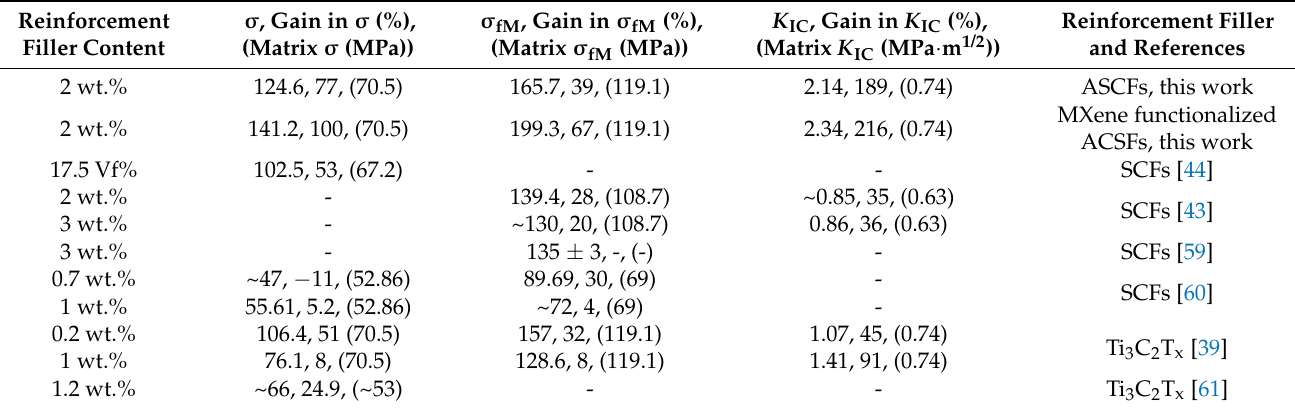
Table 3. Comparison of the tensile strength ( σ ), flexural strength ( σ fM ) and fracture toughness ( K IC ) of various composite systems, and the relative increments after incorporation of commercially available SCFs and MXene (Ti 3 C 2 T x ). Reinforcement Filler